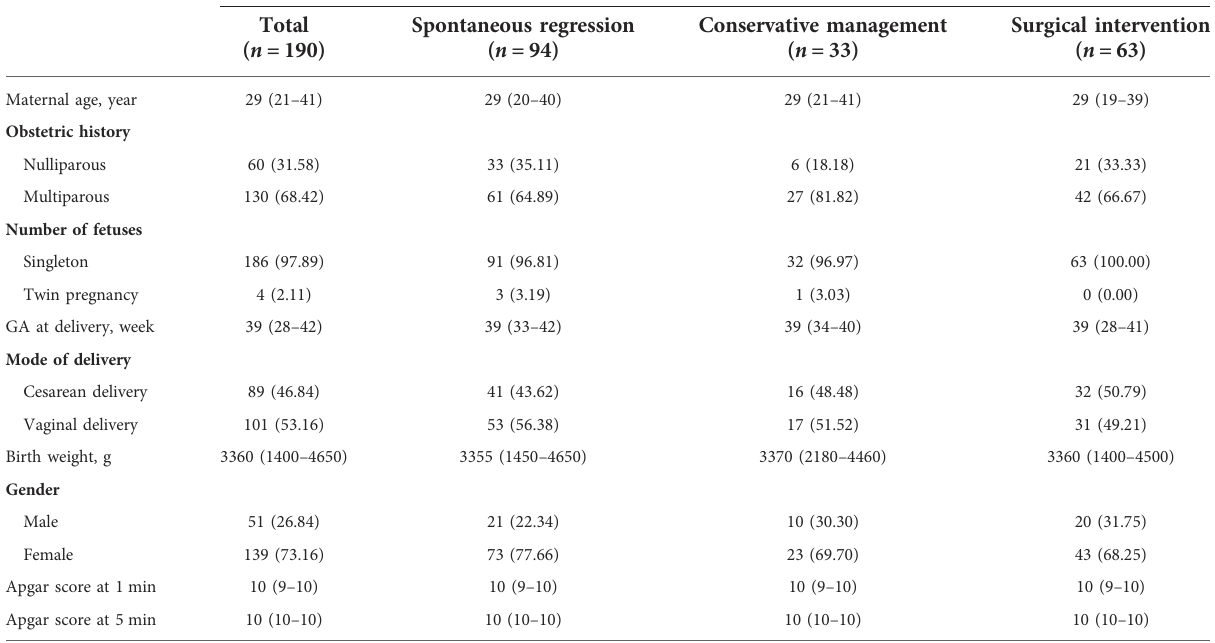
TABLE 1 Maternal and neonatal clinical